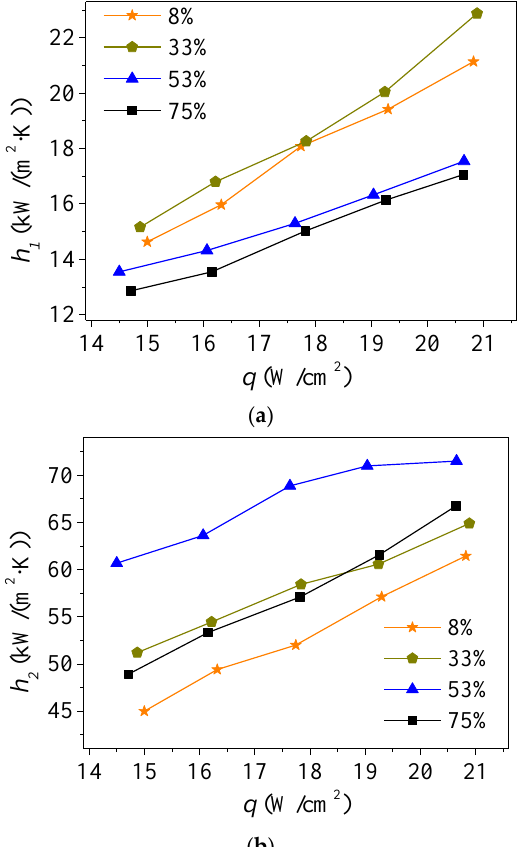
Figure 6. Effect of filling rate on the heat transfer coefficients: ( a ) evaporation heat transfer coefficient, ( b ) condensation heat transfer coefficient ( H = 20 mm).